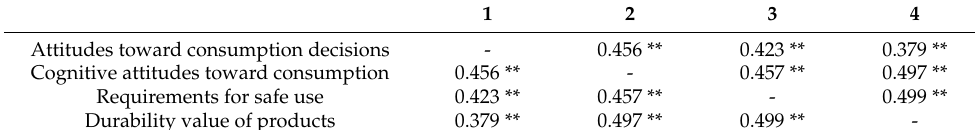
Table 9. Matrix of product life cycle and consumption value and behaviors ( N = 324).